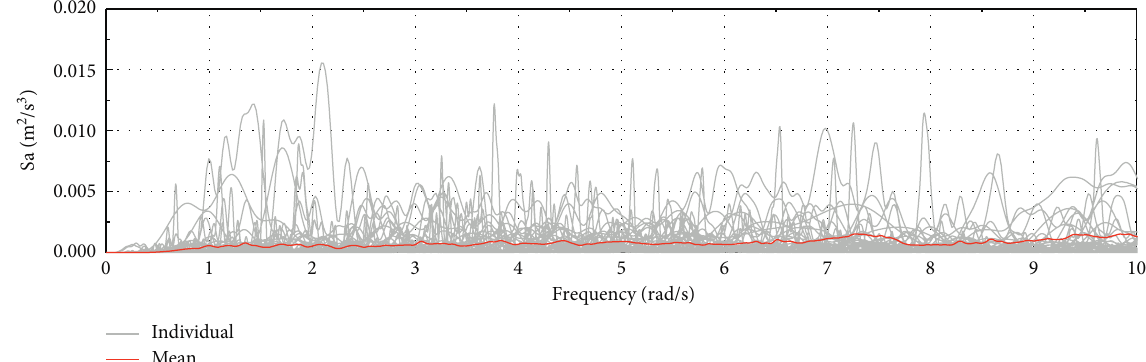
Figure 5: The individual and mean PSDs of the 44 recorded earthquakes belonging to the FEMA P695 far-field record set